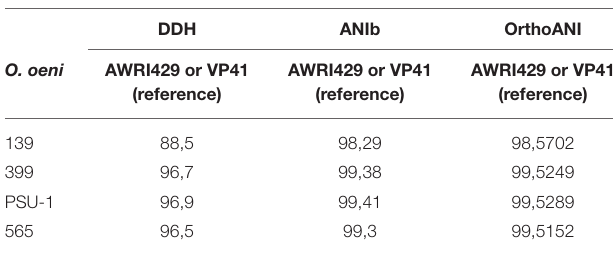
TABLE 3 | Results of DDH, ANIb, and OrthoANI algorithms of autochthonous O. oeni genomes compared to reference strain VP41.